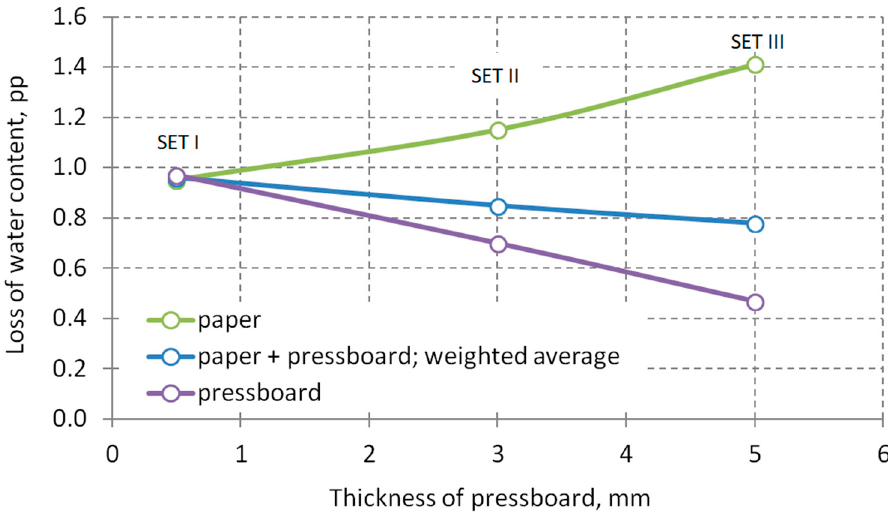
Figure 11. Loss of water content during the drying of cellulose materials by means of synthetic ester in dependence on pressboard thickness in each of the SETS: water loss in paper, in pressboard, and together in pressboard and paper taking into account the weight ratio of both materials; (SET I consists of 0.05 mm paper and 0.5 mm pressboard; SET II consists of 0.05 mm paper and 3 mm pressboard; SET III consists of 0.05 mm paper and 5 mm pressboard).